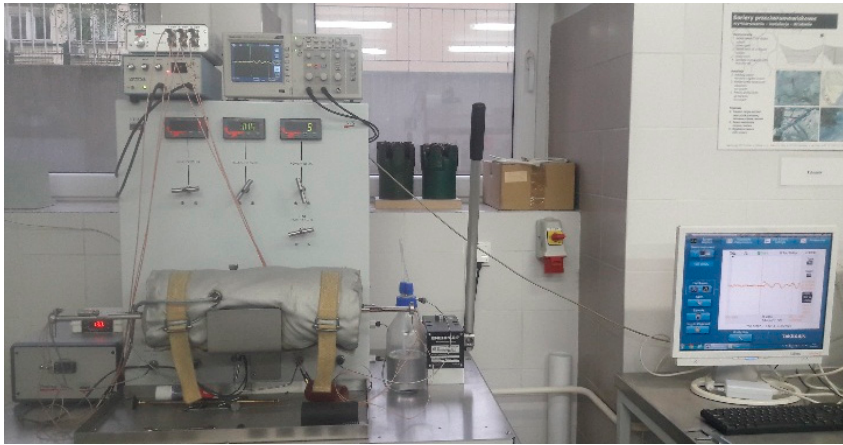
Figure 4. Acoustic velocity measurement apparatus.